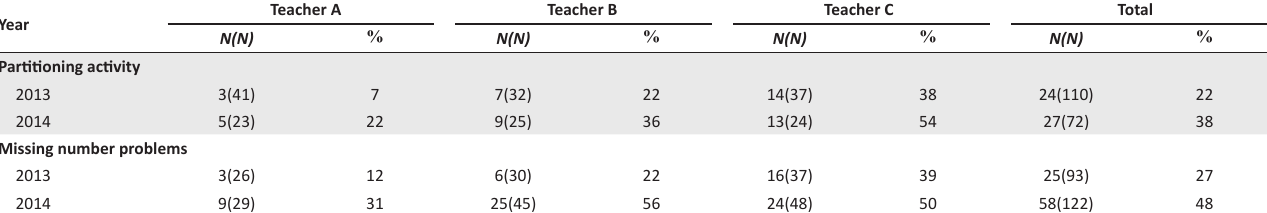
TABLE 4: Summary of segments coded as simultaneity and connections between examples, in 2013 and 2014.